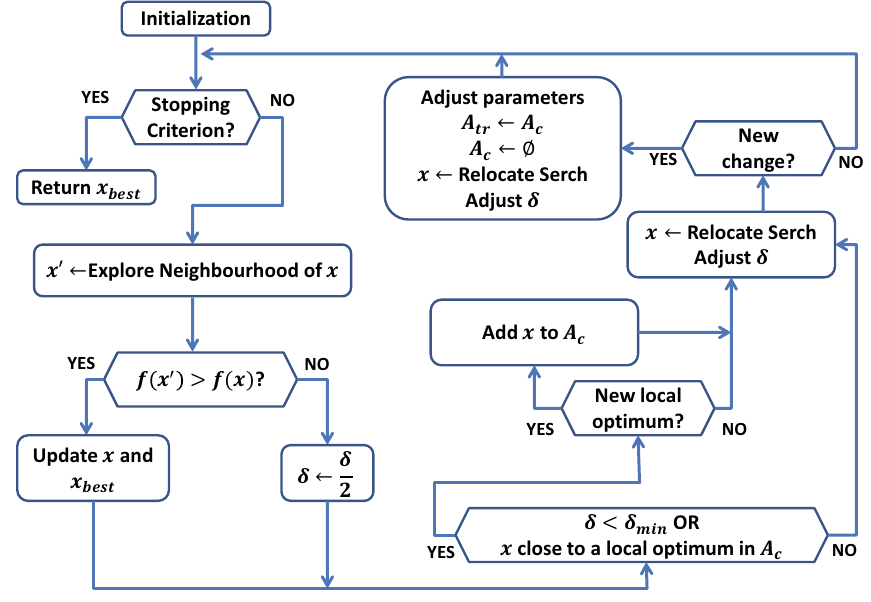
Fig. 1. Workflow of the adaptive local search